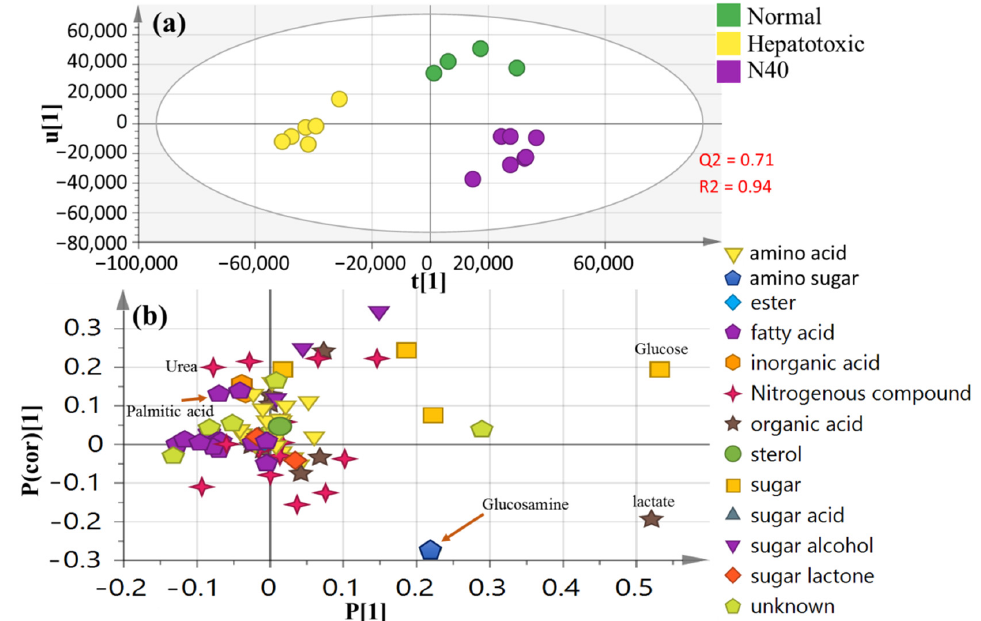
Figure 7. Supervised OPLS dataset of healthy normal, intoxicated and naringenin at 40 mg/kg groups ( n = 6): ( a ) OPLS-DA score plot for N40 (naringenin at 40 mg/kg); ( b ) the corresponding loading plot.